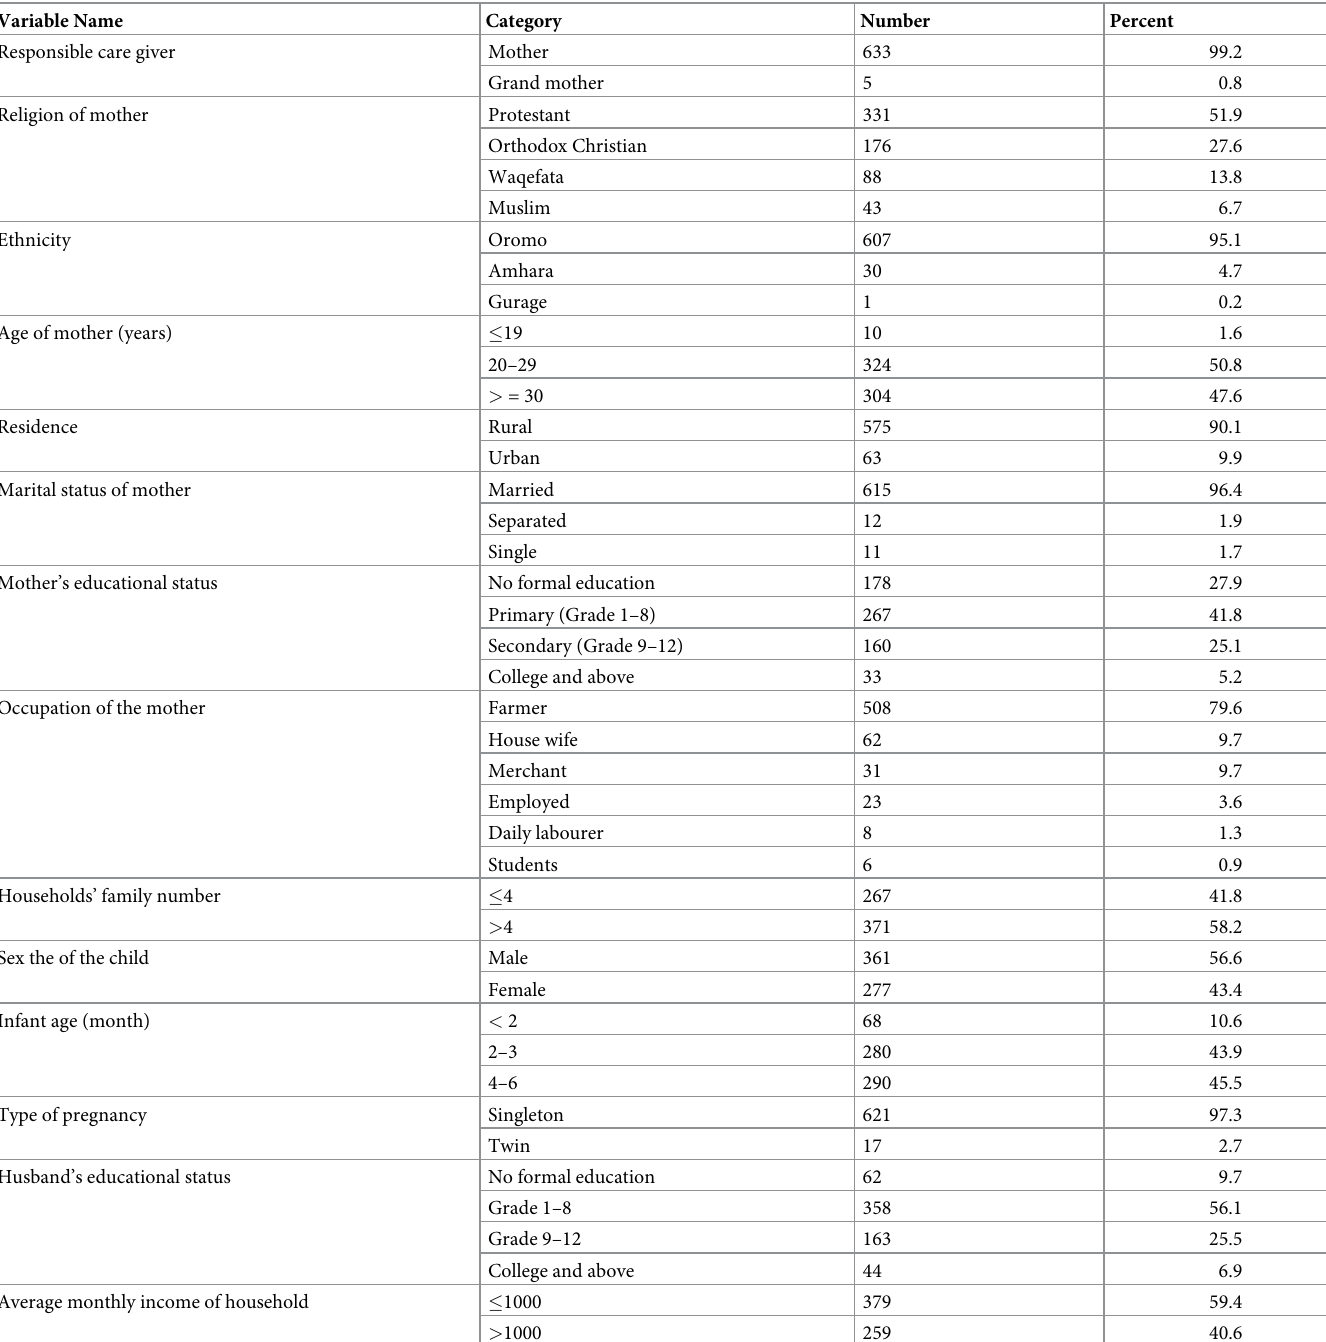
Table 1. Socio-demographic characteristics of study participants (n =